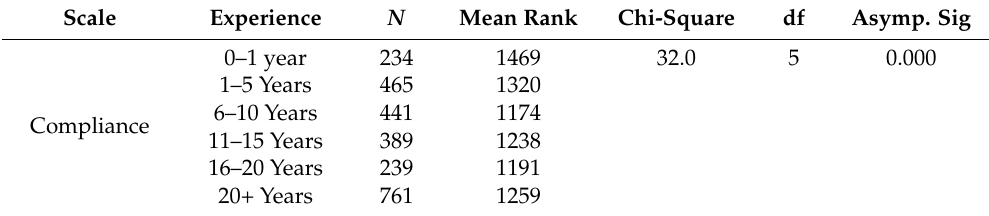
Table 6. Kruskal-Wallis results for mining experience and